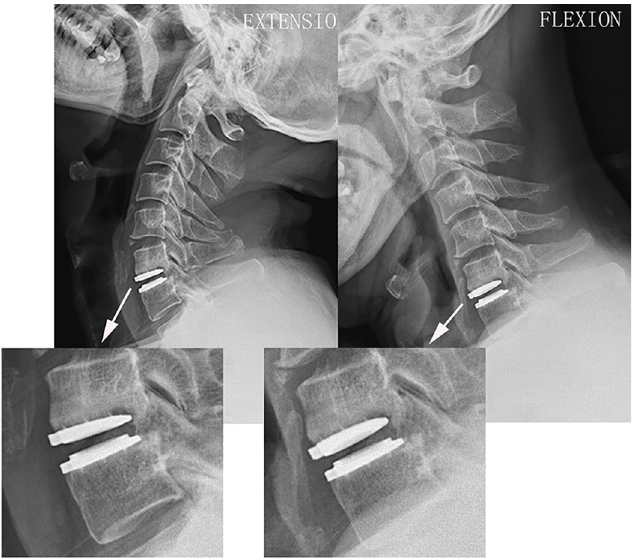
Fig 4. The representive case who suffered heterotopic ossification of Discover prosthesis postoperatively. Dynamic flexion-extension lateral radiographs at the final follow-up showing heterotopic ossification (Grade III) at the index level with significant restriction in the range of motion of Discover prothesis.